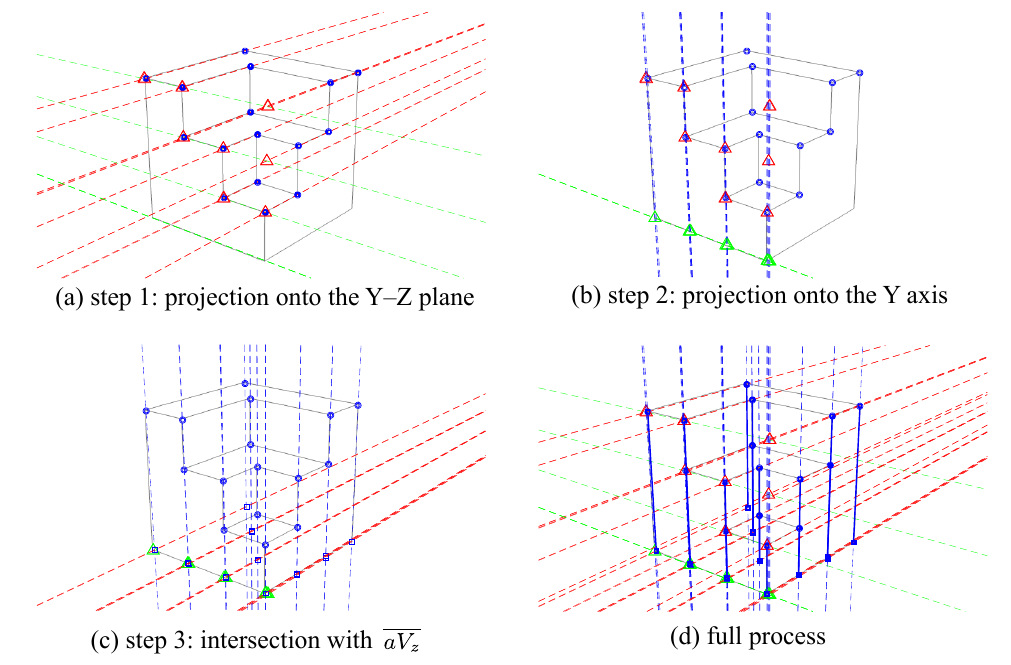
Figure 8. Base point estimation. ( a ) Blue feature points projected onto the Y − Z plane are marked as red triangles; ( b ) Red triangles projected onto the Y axis are marked as green triangles; ( c ) Base points are estimated from the intersection of aV z and lines linked from green triangles to V x ; ( d ) The solid blue lines are ab with unknown height h